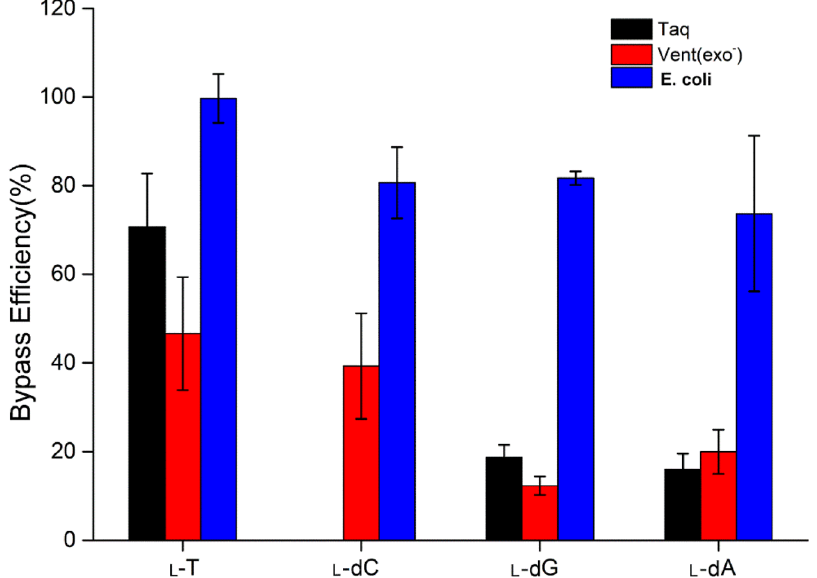
Figure 5. The bypass efficiency of replication of DNA containing l-nucleosites in cells and in vitro